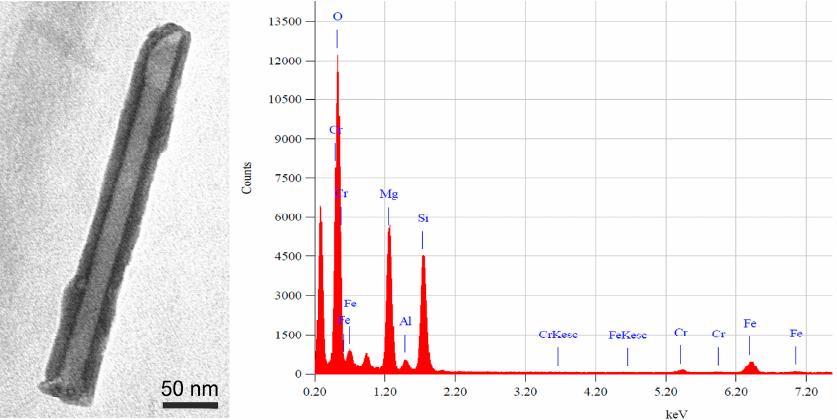
Figure 4. Single cylinder chrysotile with the relative point analysis (Spol1).